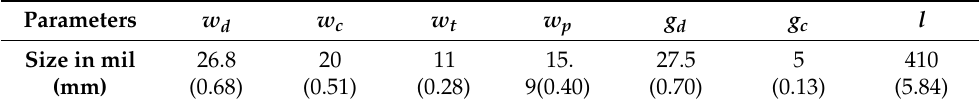
Table 3. Design parameters of the DL-to-PSL